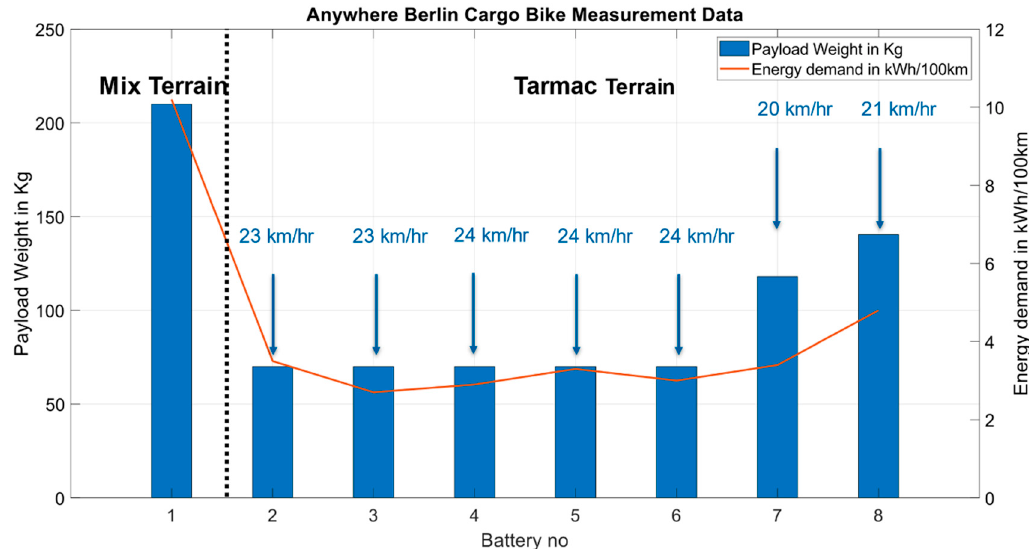
Figure 18 . Distance-related battery electricity demand depending on the road surface (Anywhere Berlin cargo bikes).